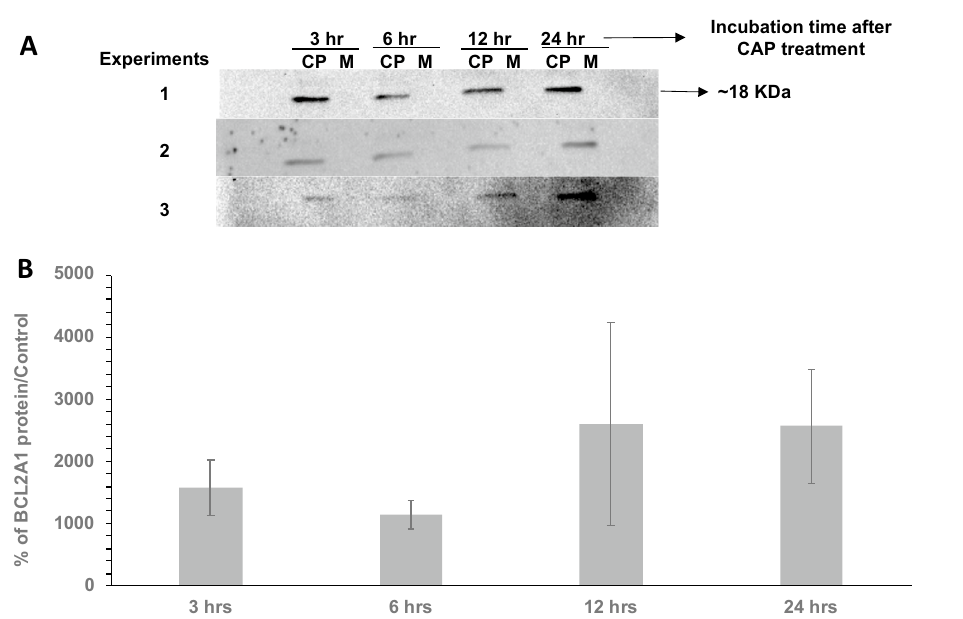
Figure 6. BCL2A1 protein if only expressed after CHCP treatment in TNBC cells. Expression of BCL2A1 after CAP treatment (CP) and mock controls (M) in TNBC cell line MDA-MB-231. Representative Western blots ( A ) and bar graph representation ( B ) of the quantification of BCL2A1 protein in total tissue lysates from MDA-MB-231 cells after CHCP treatment compared to the mock control